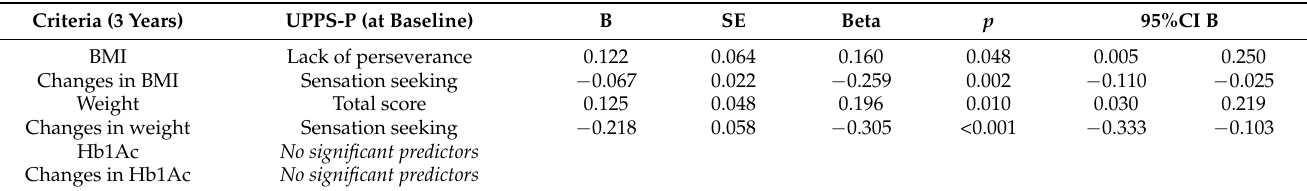
Table 2. Significant predictors at 3 year follow up, considering impulsivity measures at baseline; final models adjusted by sex, age, education and intervention group (results for the subsample of patients with